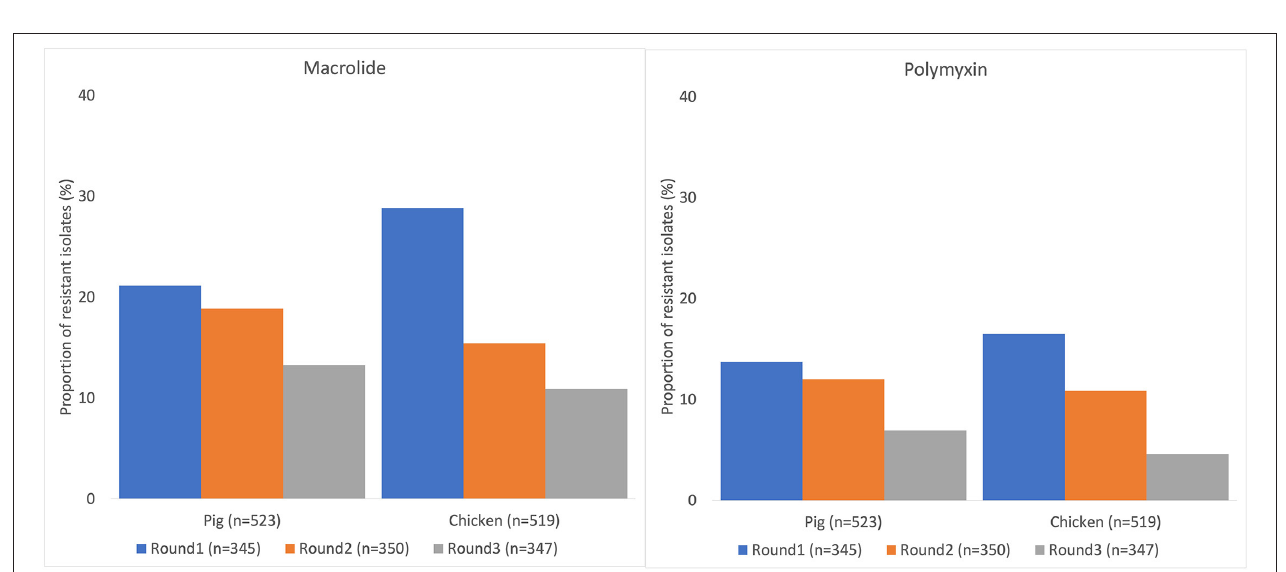
FIGURE 2 | Decreasing trend of Escherichia coli resistance to macrolide and polymyxin in pig and chicken samples collected from five provinces in Vietnam, 2017–2019.